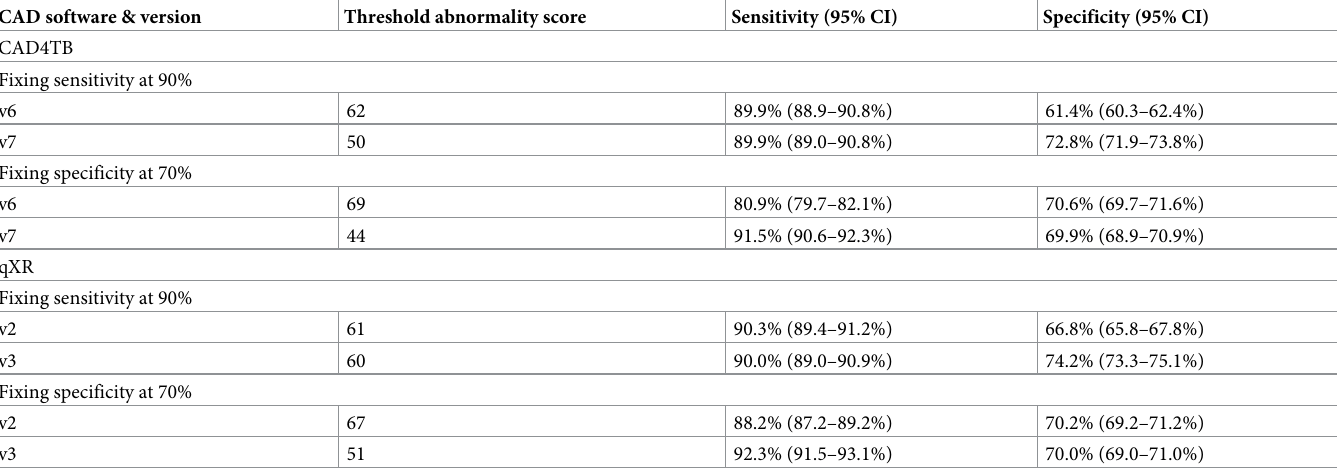
The AUCs of both newer CAD products are higher than the previous versions across all sub- groups. Overall, the AUCs of all CAD product versions were significantly higher in new cases compared to people with a history of TB: ranging from 0.846–0.918 for new cases and 0.706– 0.841 for those who had TB previously. Despite comparable sensitivity, human readers also performed worse in this group with specificity of 37.62% (34.95–40.34%) compared to 67.2%, (66.1–68.3%) where there was no TB history. (Table 4). All product versions also performed significantly worse in older populations, as did human readers. No significant gender differ- ence was noted for CAD, though human readers were less specific in males than females. Newer product versions were more proficient at accurately classifying CXRs from people with a history of TB and older individuals, especially CAD4TB v7 compared to v6 (S4 Fig, S3 Table). V3 of qXR performed significantly better than its predecessor in older and middle- aged groups, while v7 of CAD4TB significantly outperformed its predecessor in all age groups and was the only algorithm not to perform worse in middle-aged than in younger age groups. Patient source was a conspicuous factor. All versions performed significantly better among walk-ins than DOTS-retested and private referrals and human readers showed the same bias. but this shortcoming was not carried forward into CAD4TB v7. Human reader specificity was Table 3. The performance of old and new versions of CAD4TB and qXR when fixed to 90% sensitivity and to 70% specificity. CAD software &